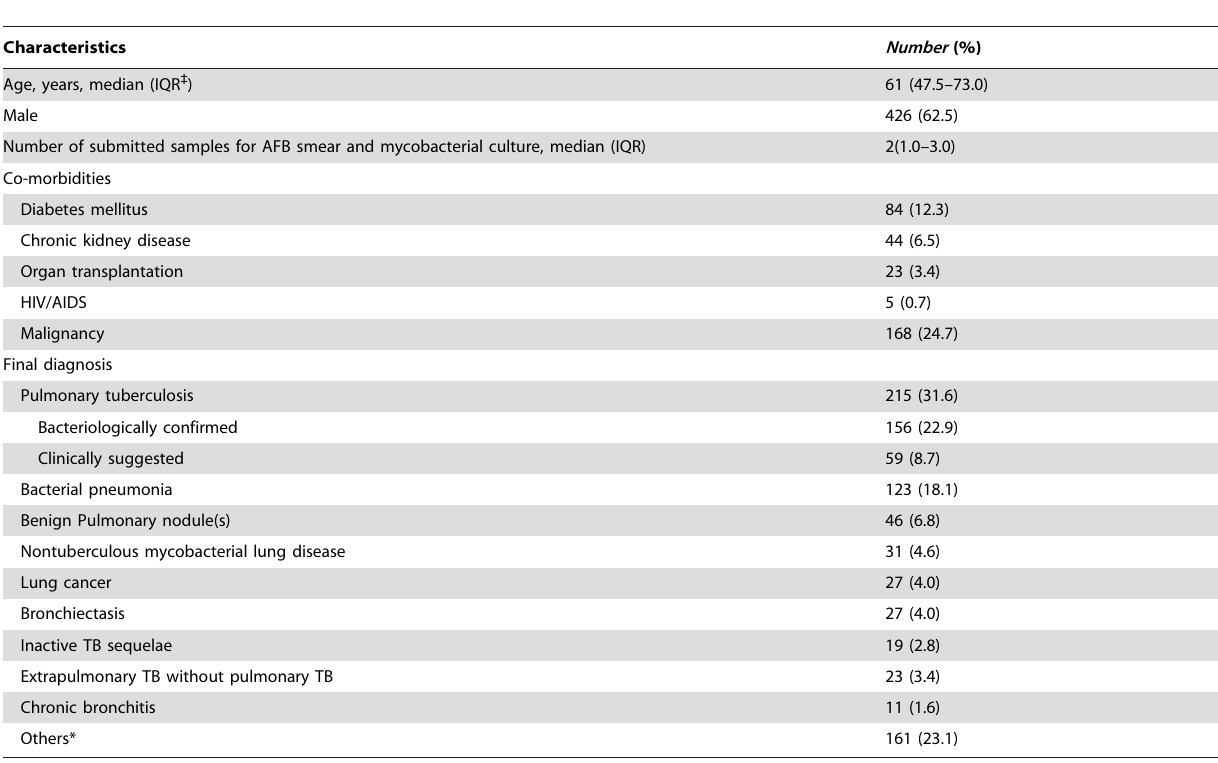
Table 1. Characteristics of the 681 patients in whom the Xpert MTB/RIF assay was requested.